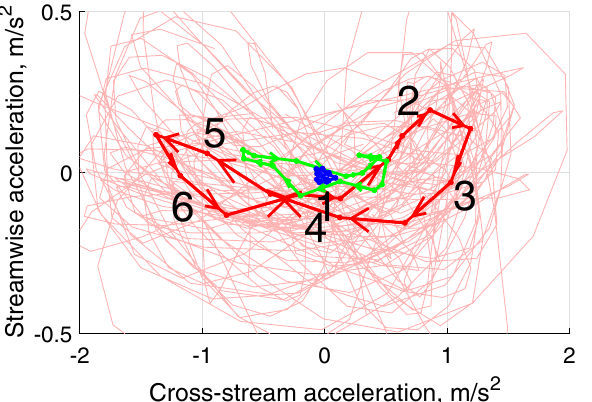
Figure 5. Phase-averaged trajectory of an individual fish in the space of cross-stream/streamwise accelerations in different swimming modes: blue—regular swimming outside the wake in the uniform flow field, red— swinging in the wake, green—swimming regimes which can not be uniquely identified. The non-averaged trajectory in the swinging regime is shown by the pale red line. Observe the well-defined figure of eight in swinging mode, when the fish ’pushes off’ the cross-stream flow to produce positive streamwise acceleration. The figure shows phase trajectory of fish #1 recorded for 22 s. The foil oscillation frequency is 2 Hz.